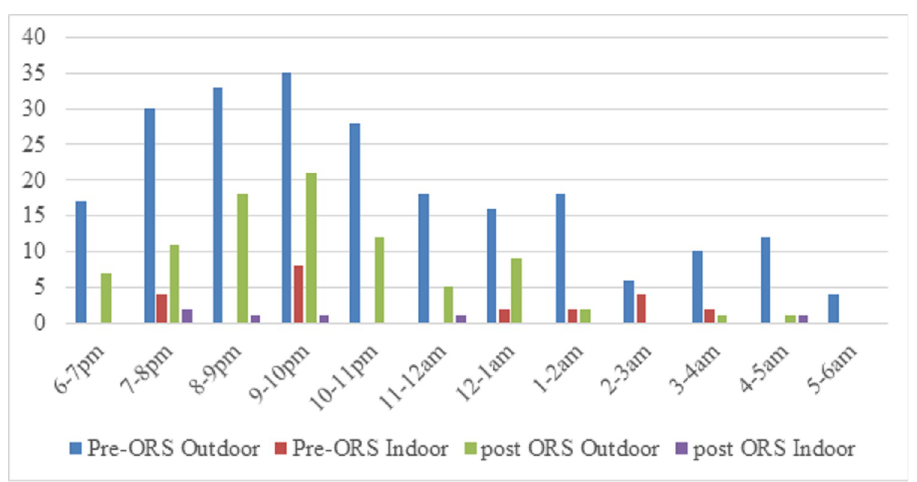
Fig 11. Outdoor and indoor biting activities of An . balabacensis before and after spraying.